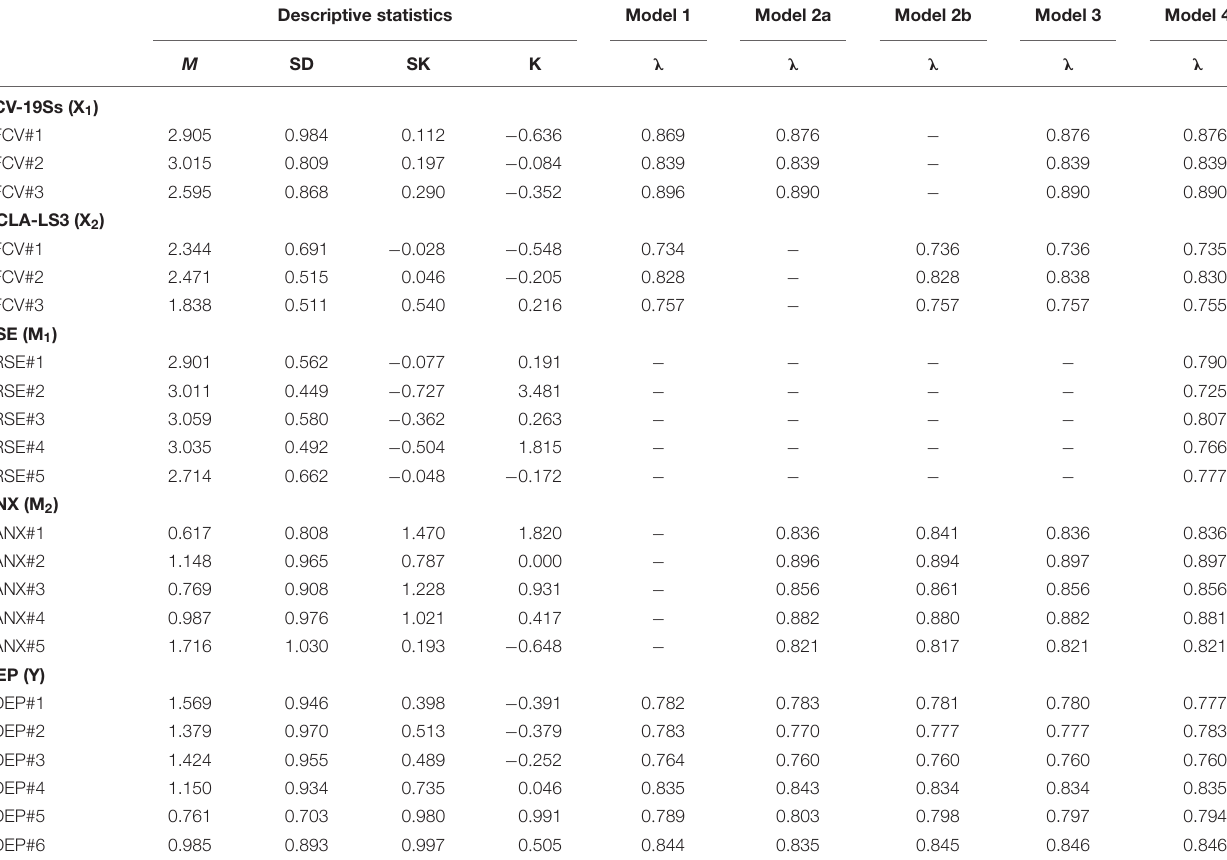
TABLE 3 | Parcel descriptive statistics and standardized factor loadings ( λ